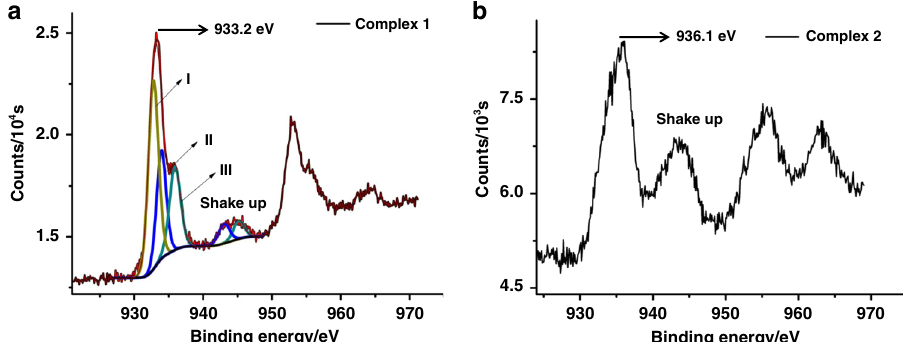
Fig. 3 XPS Characterizations. a XPS spectrum of 1 for Cu 2p (brown) with three fi tting peaks I – III (Cu(I): yellow; Cu(I) ′ : blue; Cu(II): green). b XPS of 2 for Cu 2p